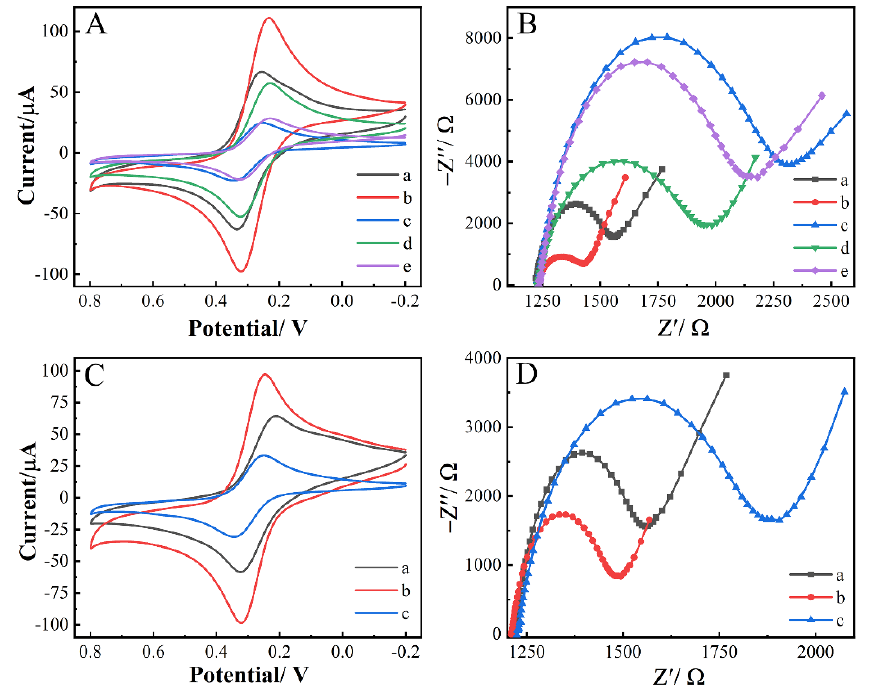
Figure 2. CV ( A ) and EIS ( B ) responses of (a) PAE, (b) Au–PAE, (c) MIPsAu − PAE, (d) MIPs − Au − PAE after template removal, (e) MIPs − Au − PAE after template rebinding; CV ( C ) and EIS ( D ) responses of PCE (a), CNT − PCE (b), and BOD − CNT − PCE (c).